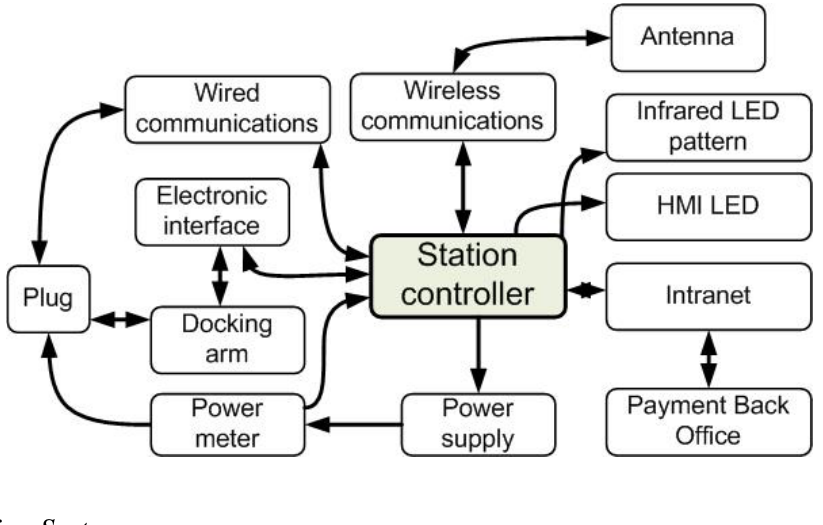
Figure 3. Recharging and docking station on the AMARE